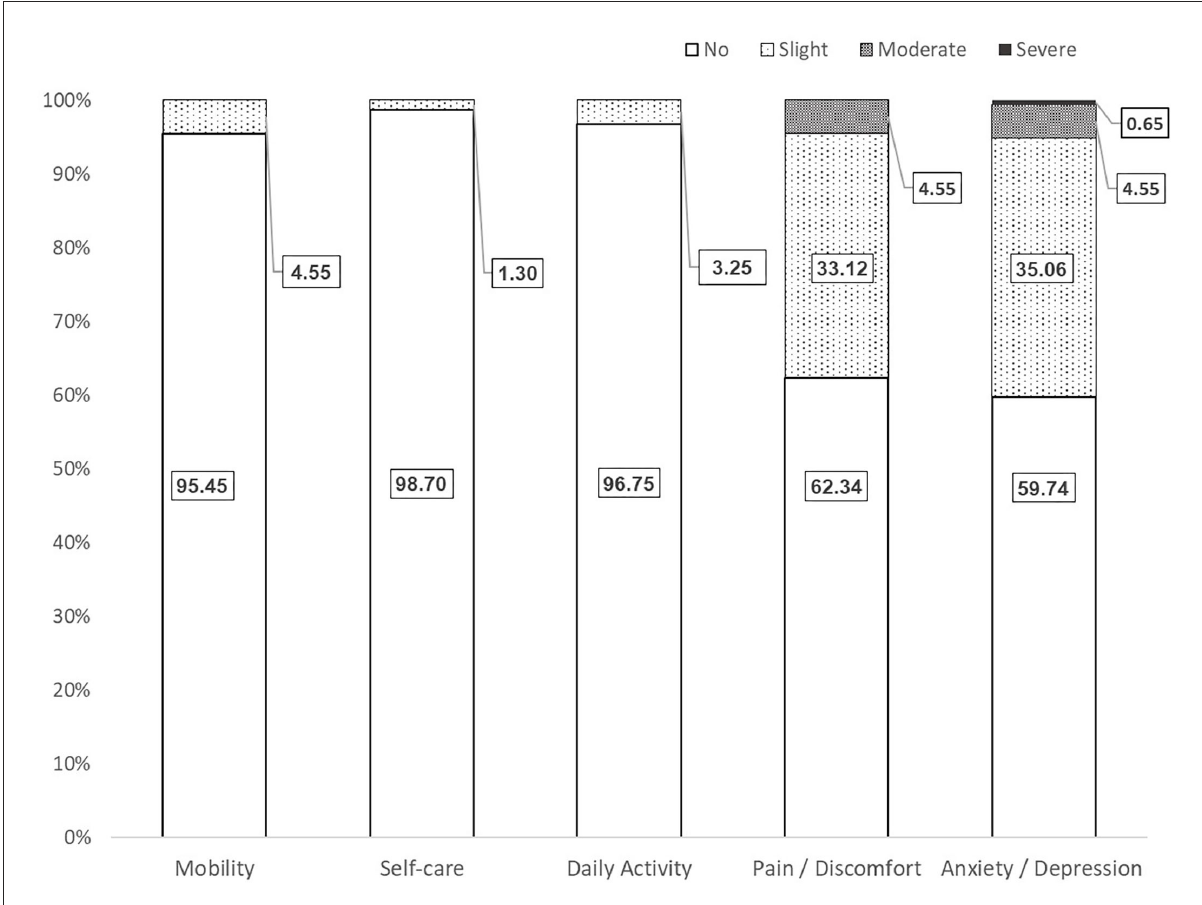
FIGURE2 Health-related quality of life profile in EQ-5D domains. Numbers are